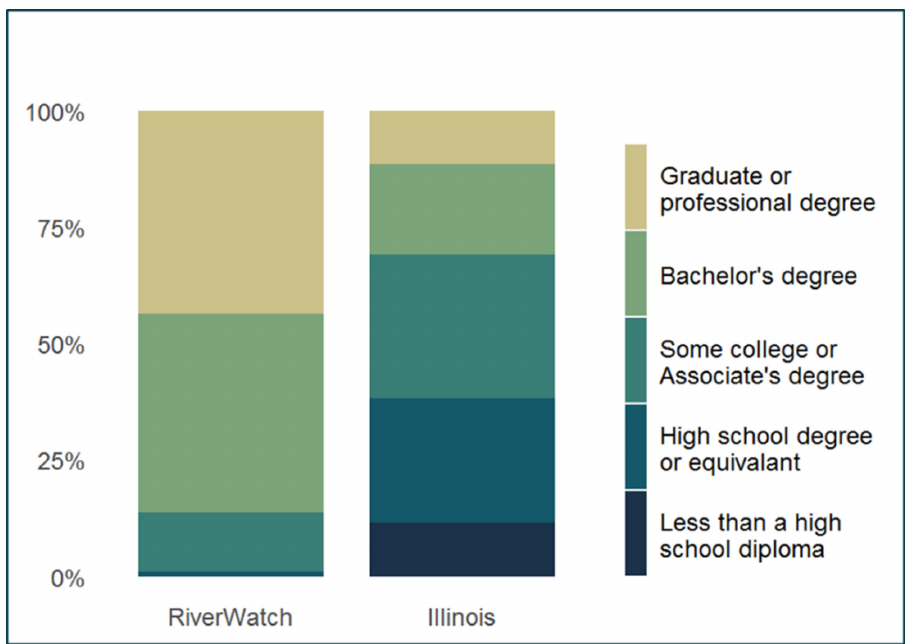
Figure 2: Education demographics of RiverWatch citizen scientists from participant surveys (N = 95) compared with the demographics of the Illinois population as a whole from the American Community Survey (2012–2016).